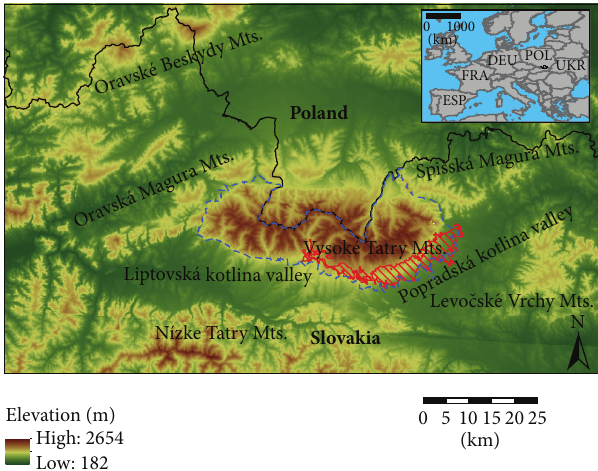
Figure 1: Geographical and geomorphological situation around the Tatra Mts. and Tatra National Park. Solid line represents state boundary between Slovakia and Poland. Dashed line represents border of the Tatra National Park. Area with left-hatching represents windstorm calamity in 2004. Black point in the index figure indicates location of the study area in European